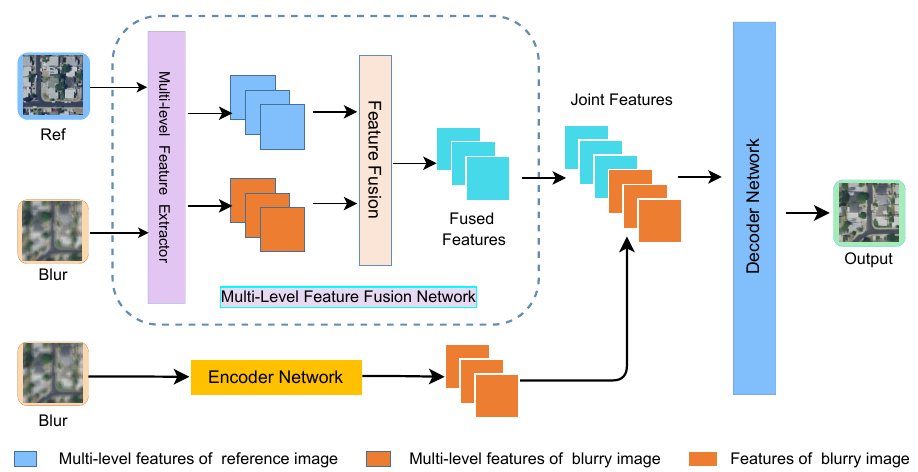
Figure 1. The overall architecture of